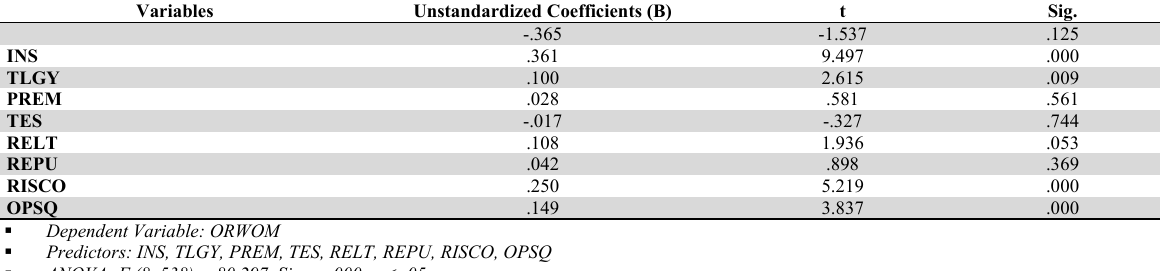
Coefficients between Independent Variables, OPSQ and ORWOM